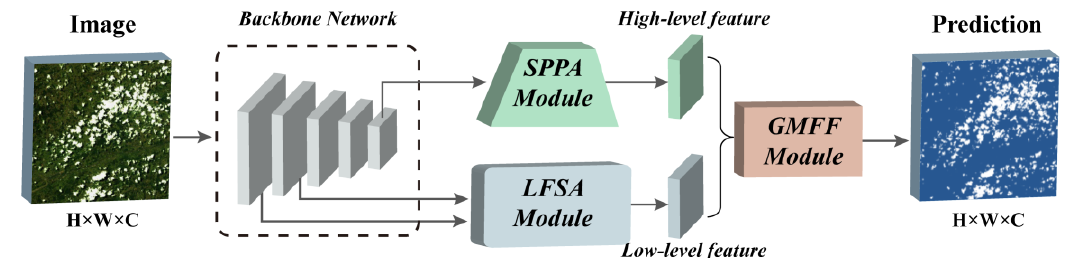
Figure 1. An overview of the multiscale fusion gated network (MFGNet) for cloud segmentation based on the dual-branch CNN architecture. Abbreviations: SPPA, spatial pyramid pooling attention; LFSA, low-level feature spatial attention; GMFF, gated multilevel feature fusion.